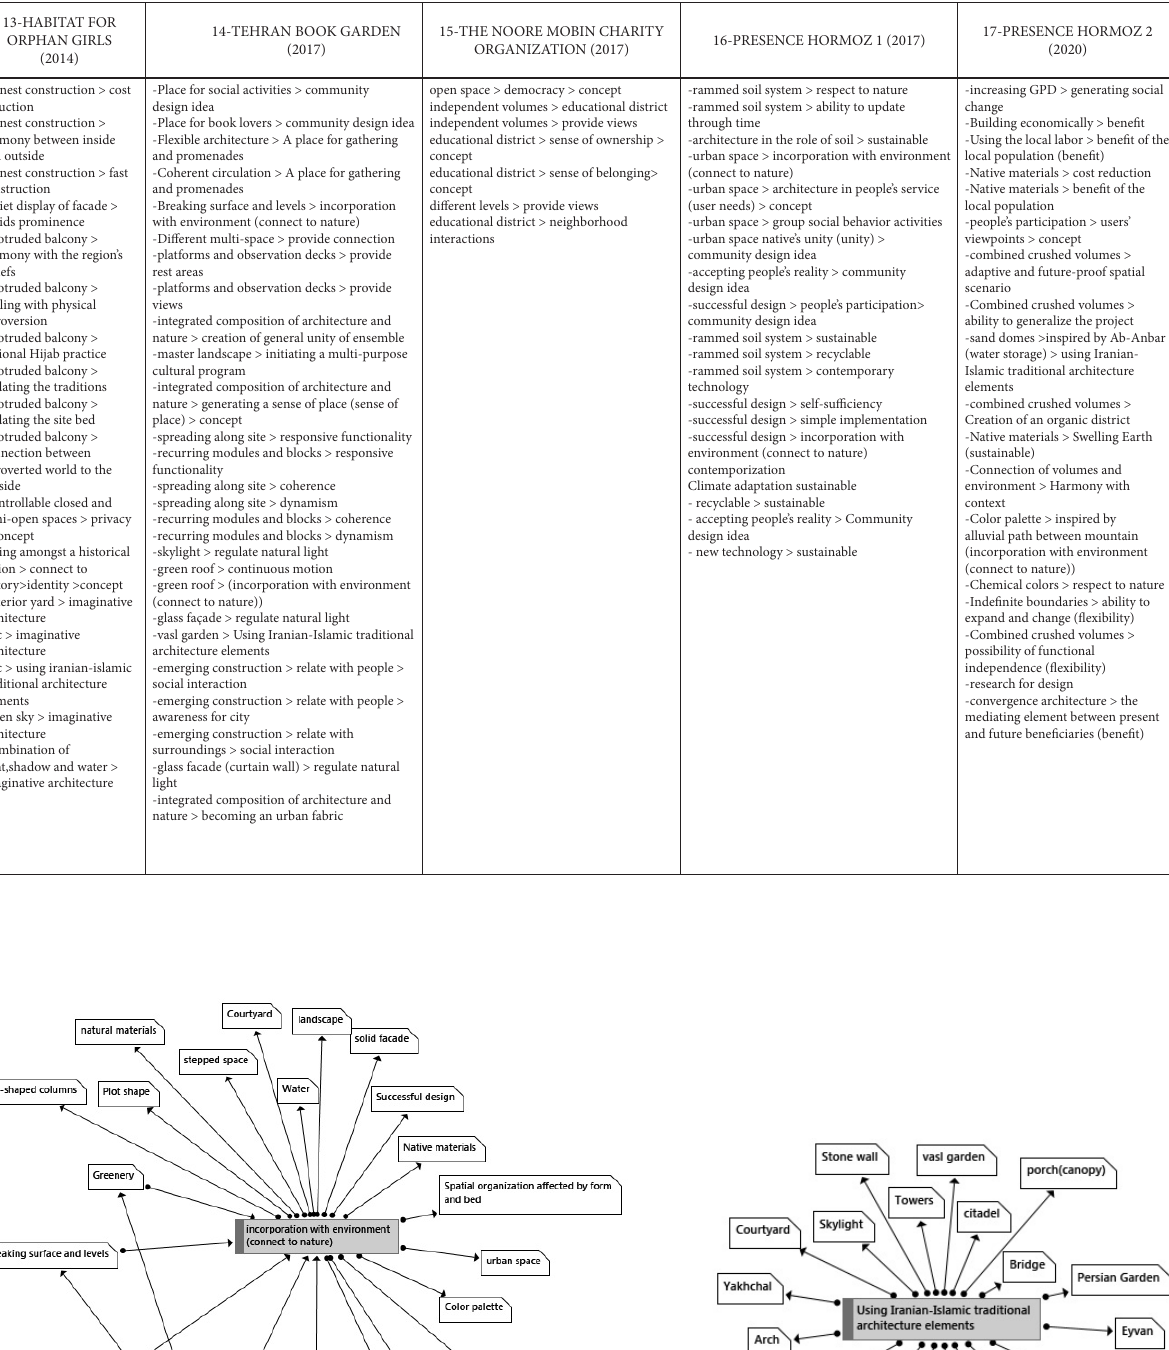
elements of the